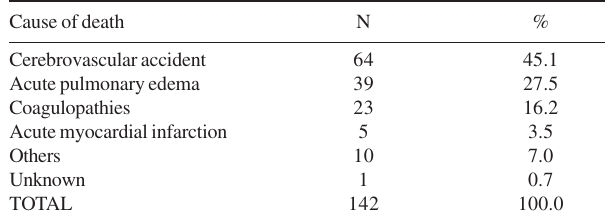
Figure 1 - Percent distribution and the respective maternal mortality rate (MMR) of cases of maternal death resulting from disorders in pregnancy of preeclampsia/eclampsia (PE/E) and chronic hypertension (CH) according to age of the pregnant women or puerpera at the time of death (São Paulo City, 1995-1999).